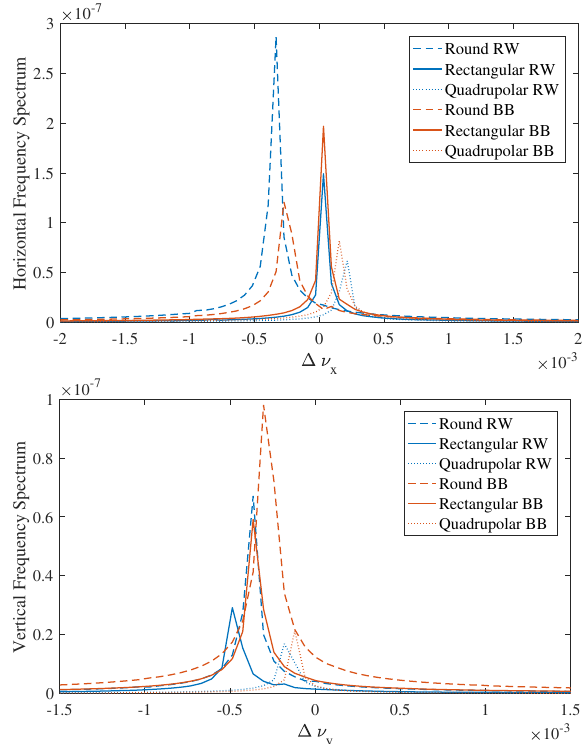
FIG. 17. Frequency spectrums of beam centroid motion. The tune shift due to the quadrupolar wakefield in rectangular chamber is shown as well.